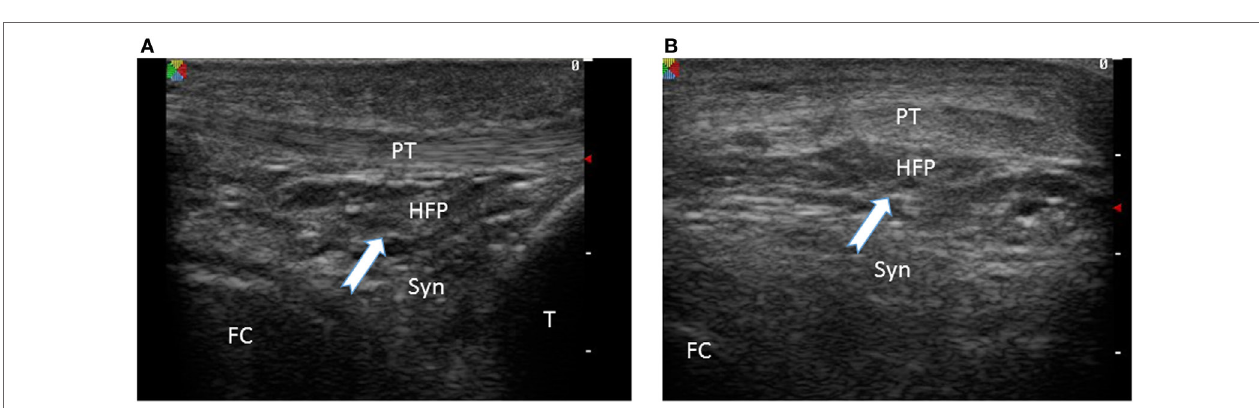
FiGUre 2 | Ultrasound image of infrapatellar fat pad of a normal knee joint White arrow indicates the fat tissue with distinct ultrasound features compared to the underlying patellar tendon (PT) and synovial tissue (Syn). HFP, Hoffa fat pad; FC, femoral condyle; T, tibia. (a) Sagittal view, (B) coronal view.